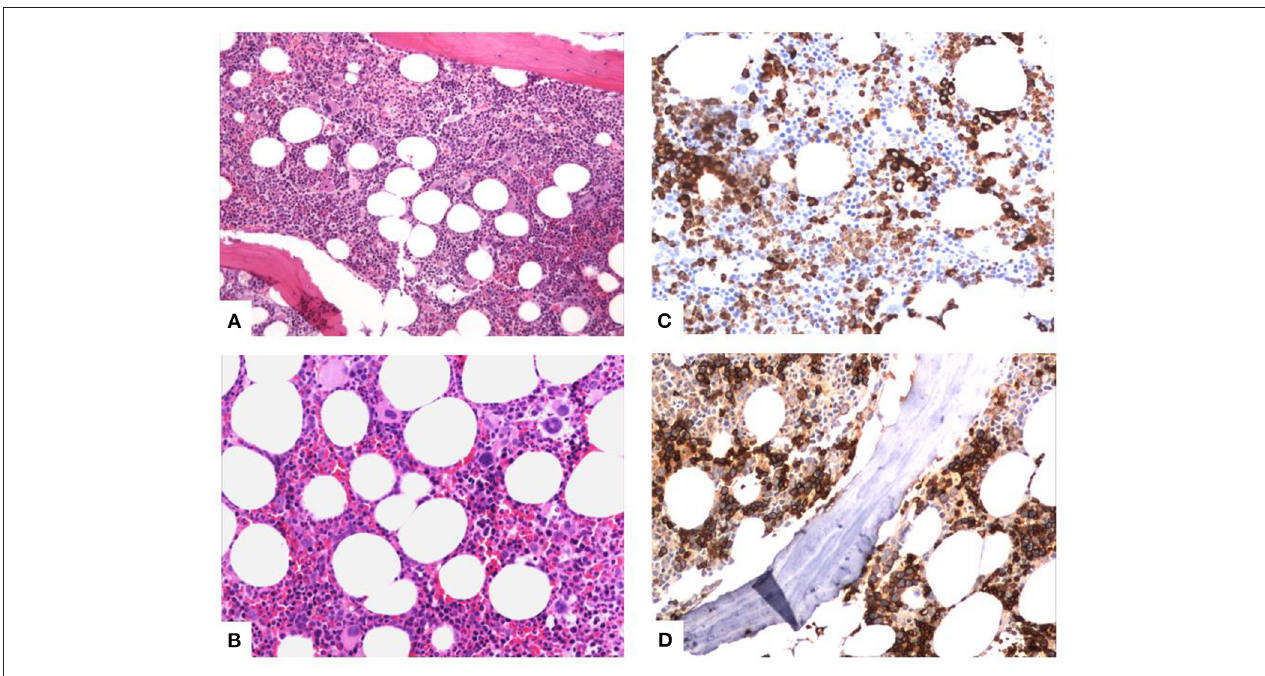
FIGURE 3 | Characteristic pictures of the bone marrow biopsy. (A) Hypercellular bone marrow with panmyelosis (trilineage hyperplasia). (B) Diversity in nuclear morphology of the megakaryocytes (multi- or monolobated forms, irregular chromatin distribution). (C) Aggregates of immature myeloid precursors in the intertrabecular region (myeloperoxidase stain). (D) Abnormal localization of erythroblasts (some with megaloblastic features) on the endosteum of the trabecular bone (Glycophorin C